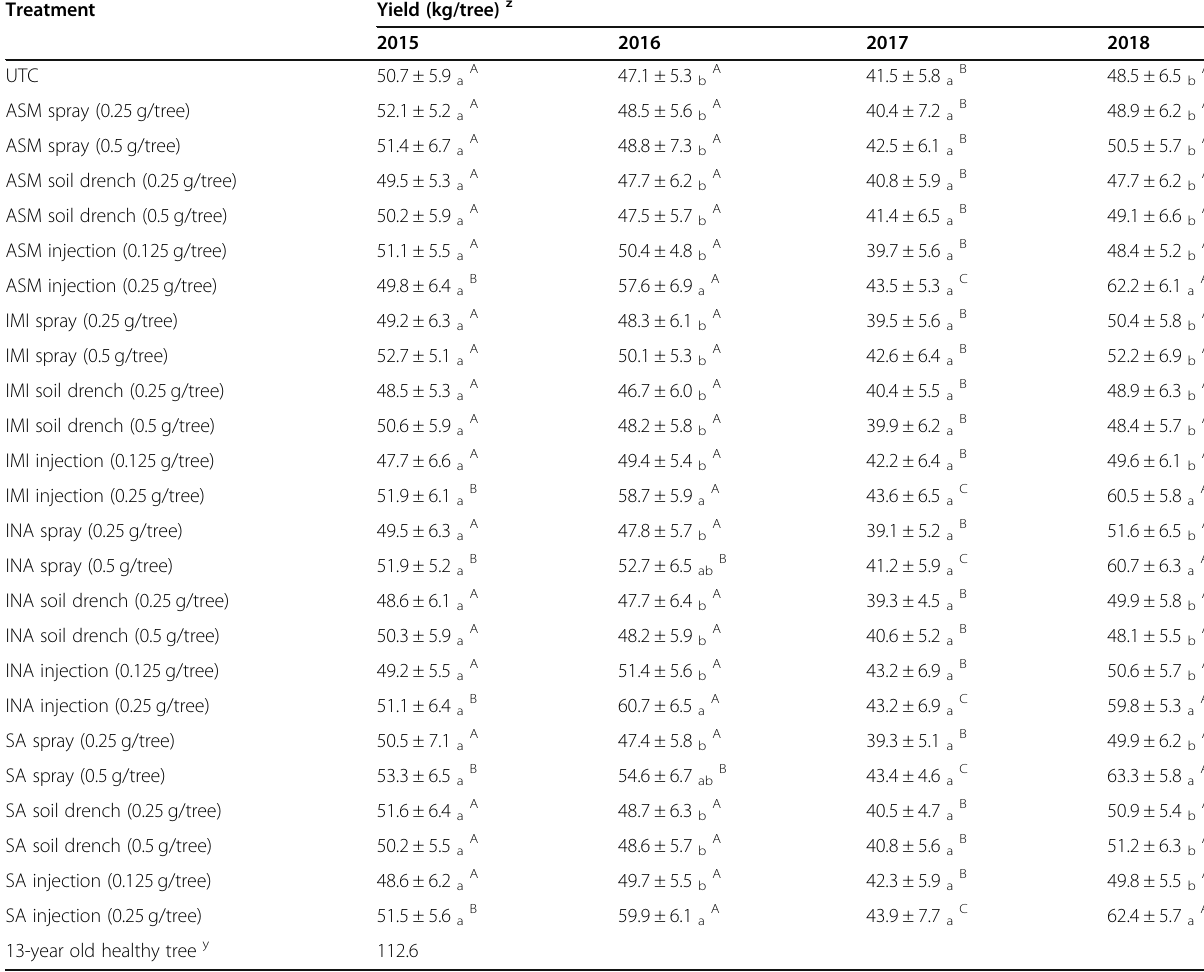
Table 2 Fruit yield of Hamlin sweet orange trees treated with various SAR inducers in a three-year field trial (2015 – 2018)